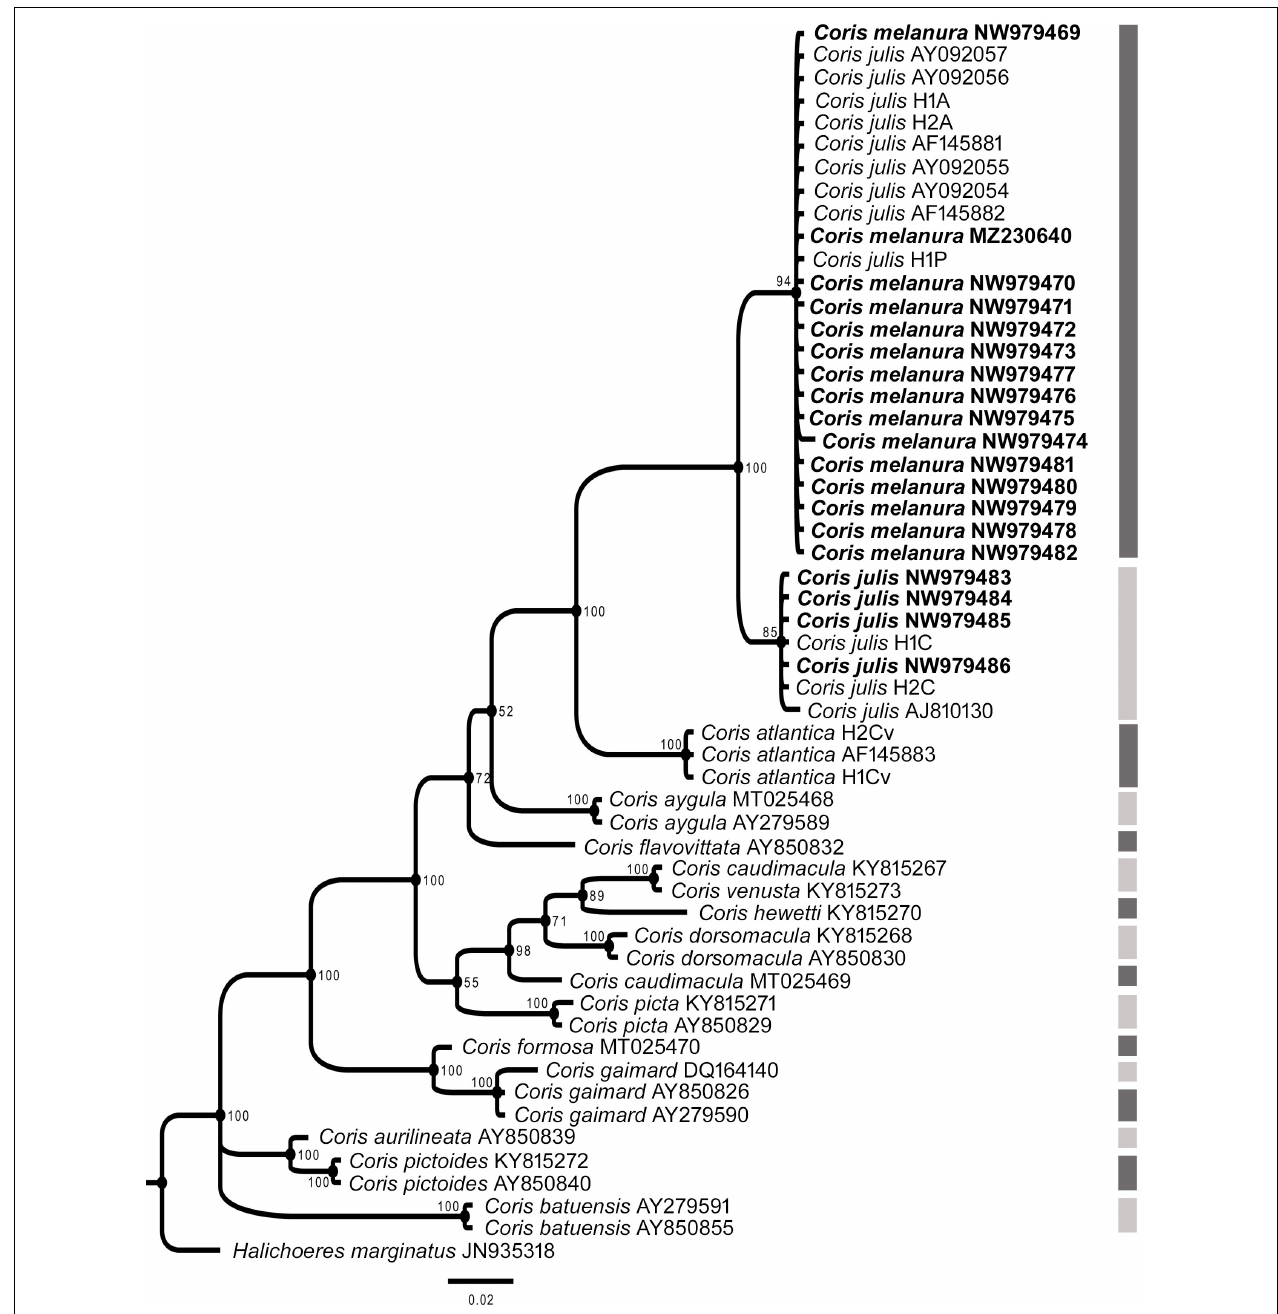
FIGURE 6 | Phylogenetic relationship based on Bayesian Inference (BI) for 12s rRNA fragment for Coris species. Posterior probabilities (%) and GenBank accession numbers are indicated near the nodes and the species name, respectively. Species delimitation analysis using Poisson Tree Process (bPTP) is indicated by lateral dark and light gray side bars. The samples analyzed here are indicated in